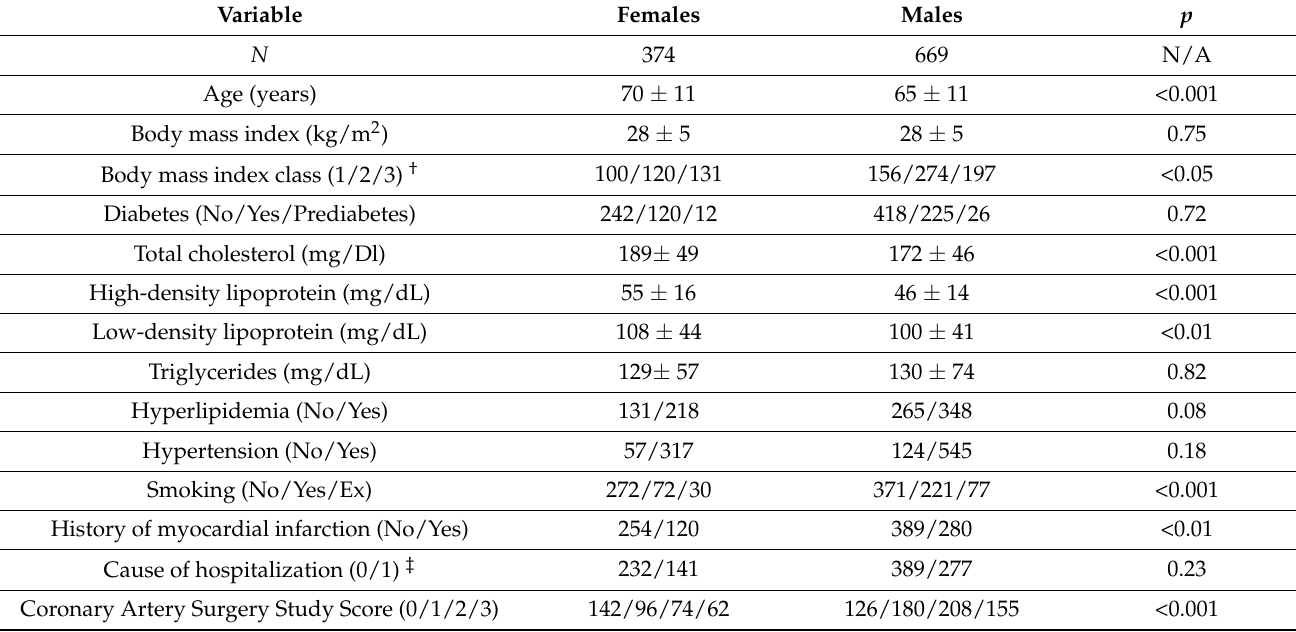
Table 1. Results between female and male